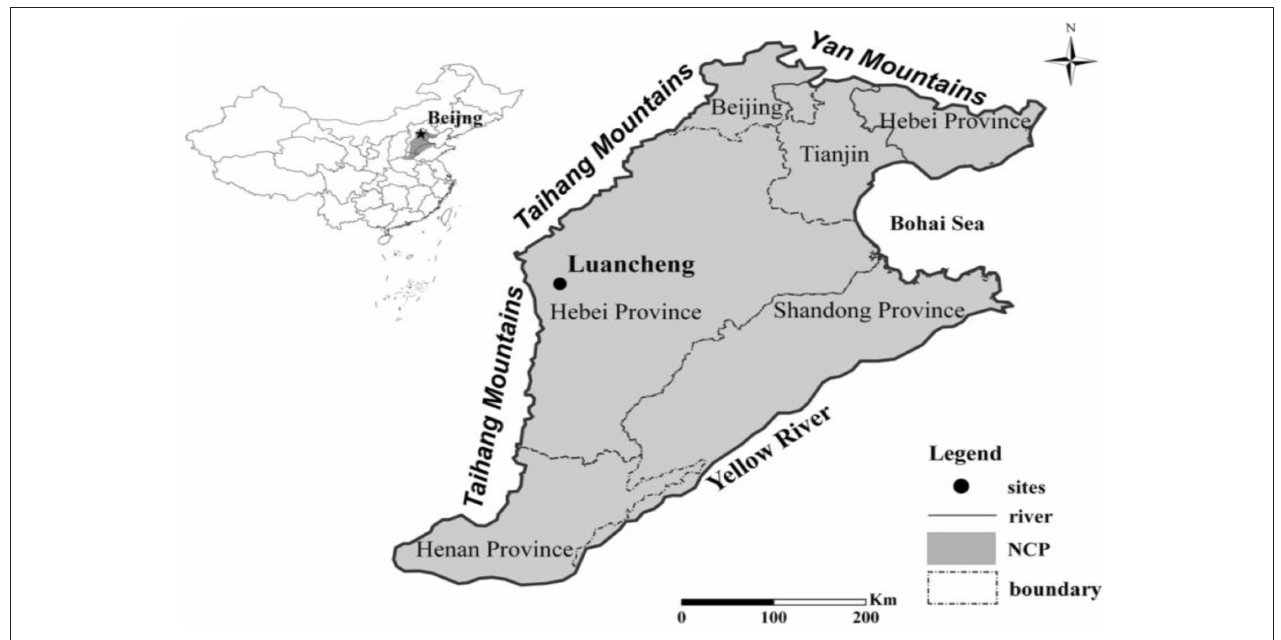
FIGURE 1 | Location of Luancheng Agro-Ecosystem Experimental Station (LAEES) in the North China Plain.